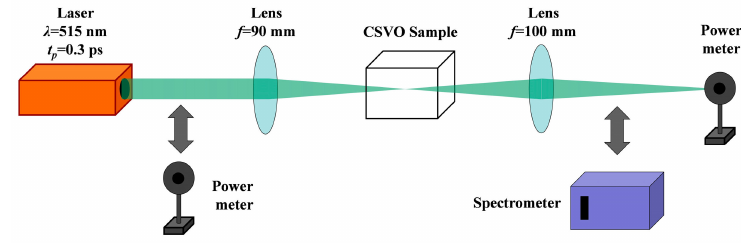
Figure 2. Optical scheme of the